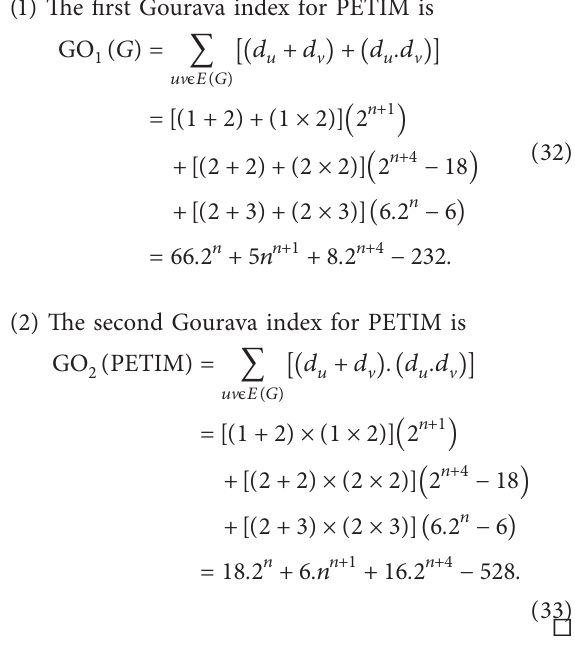
Table 8: Degree-based edge partition of